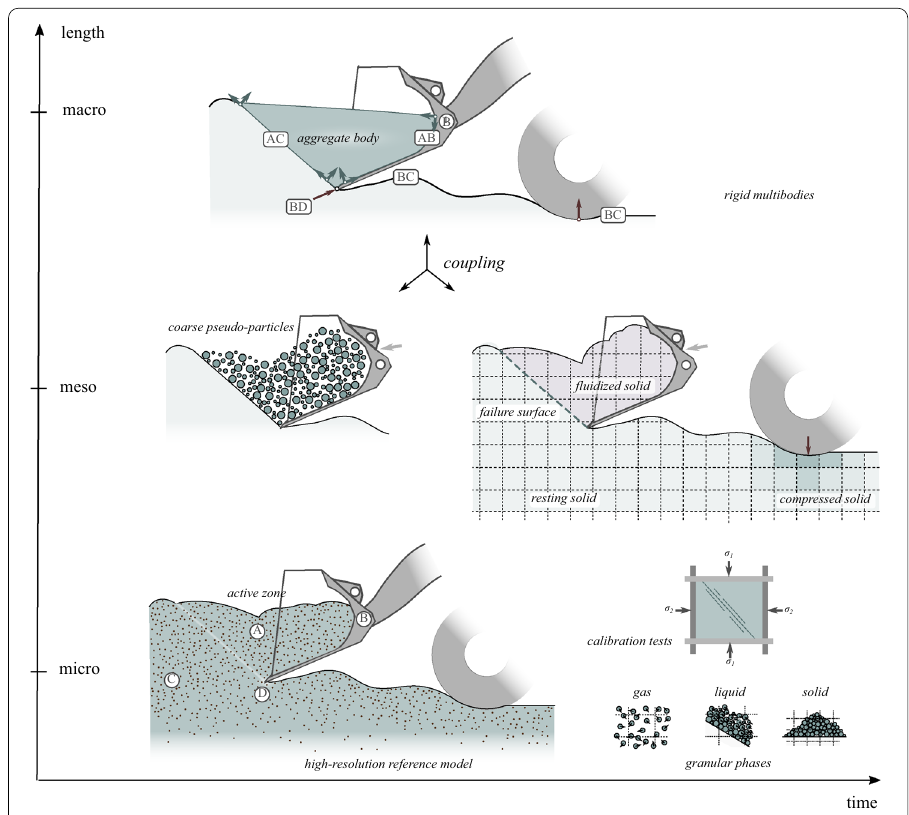
Fig. 2 Overview of the multiscale model. The mesoscale and macroscale models are simulated in real-time coupled to each other while the microscale model is simulated off-line for the purpose of model testing and calibration. The mesoscale model combines a coarse particle and continuum representation of the soil inside the active zone. The active soil is aggregated into a single body, present in the macroscale model, with